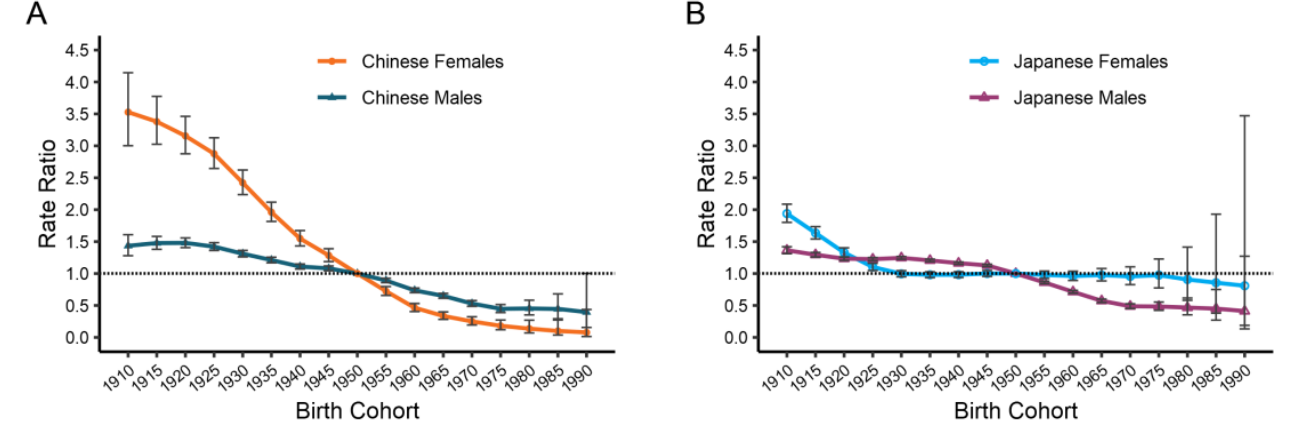
Figure 7. Cohort effects of esophageal cancer mortality by genders in China ( A ) and Japan ( B ). The relative risk of each cohort compared with the reference cohort (the 1950s) adjusted for age and nonlinear period effects and the corresponding 95% CI.